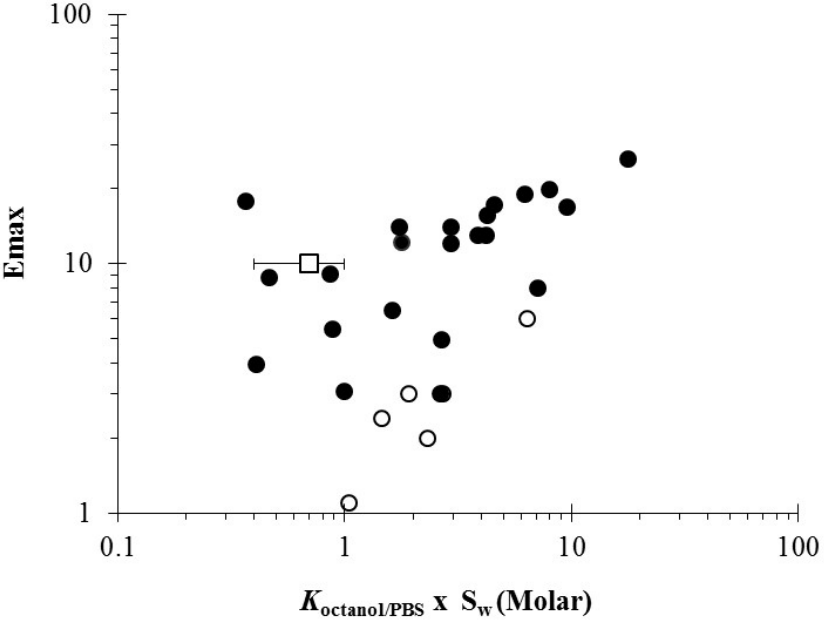
Figure 6. Relationship between Emax (the maximum enhancement effects) and the product of K (octanol/PBS partition coefficient) and Sw (aqueous solubility of octanol/PBS enhancer) of the penetration enhancers (closed circles: enhancers, liquid at 37 °C; open circles: enhancers, solid at 37 °C). The average lipid concentration of enhancers to induce E = 10 in the symmetric studies, in which the enhancers were not at saturation, is also presented for comparison (open square). The data are taken from previous human epidermal membrane (HEM) studies